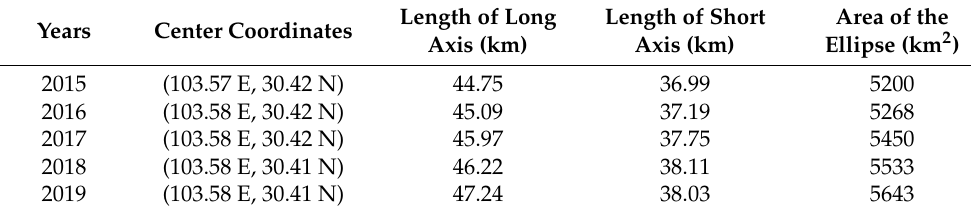
Table 3. Standard Deviation Ellipse data of the urban built-up area in Chengdu. Years Center